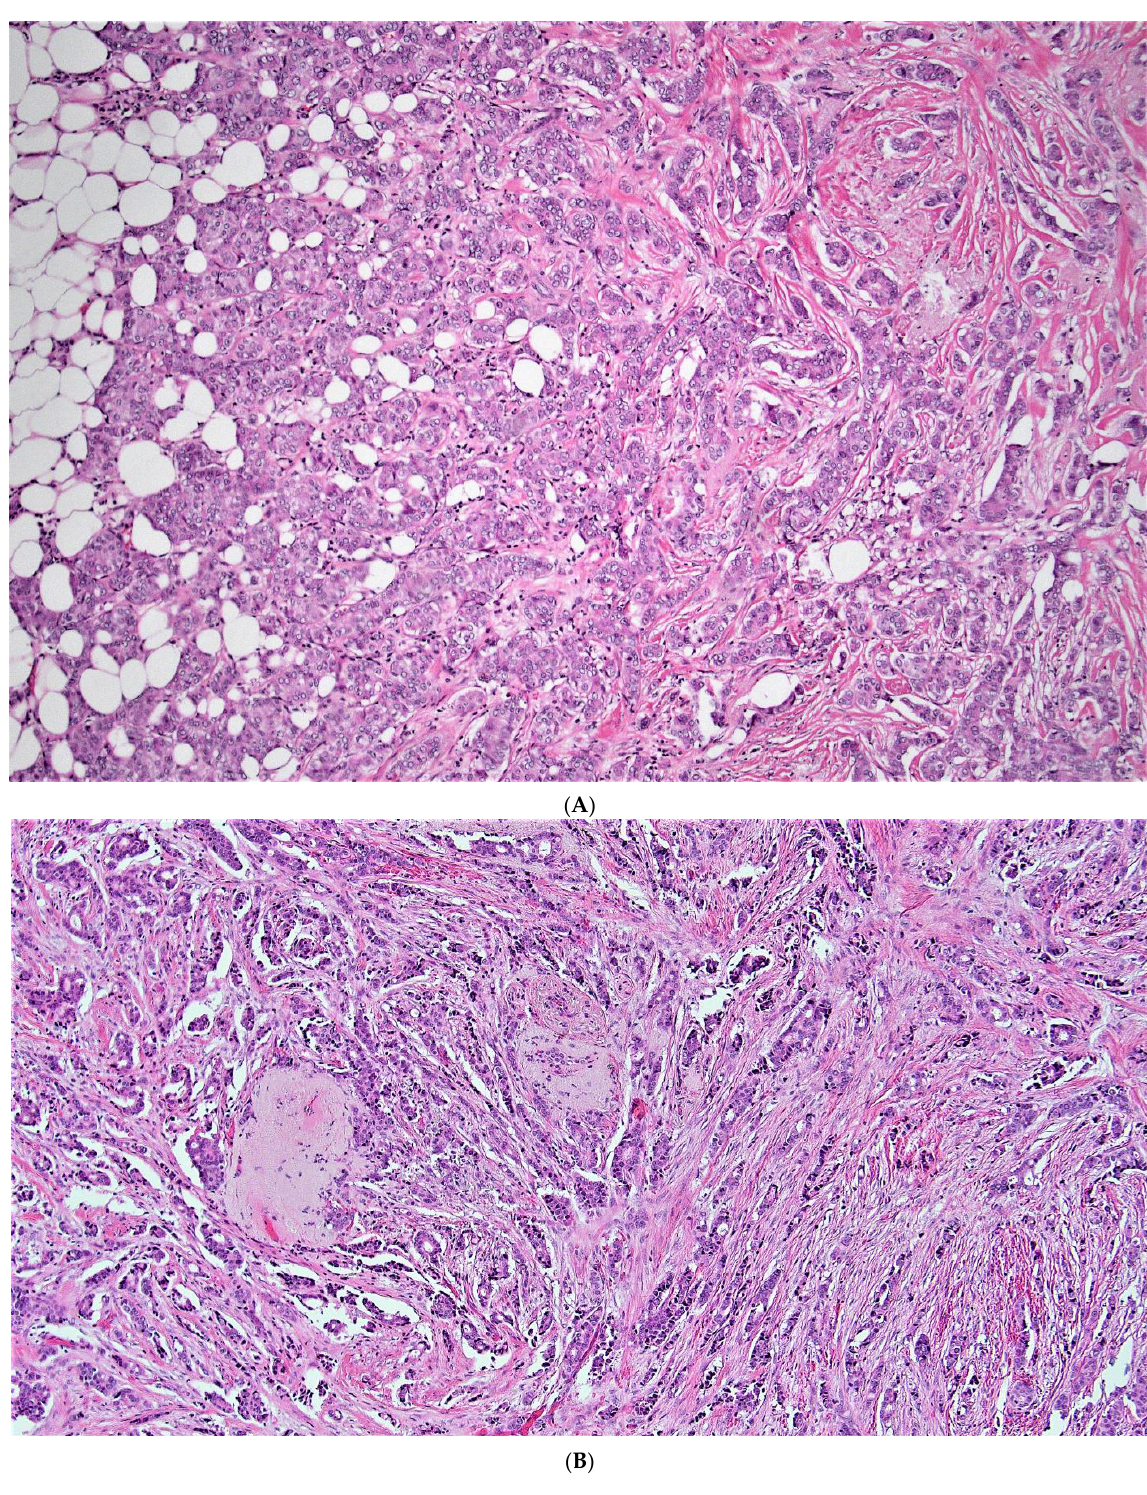
Figure 4. ( A , B ) (10 × ): The two low risk aMMs patients considered to be high risk by ODX with a